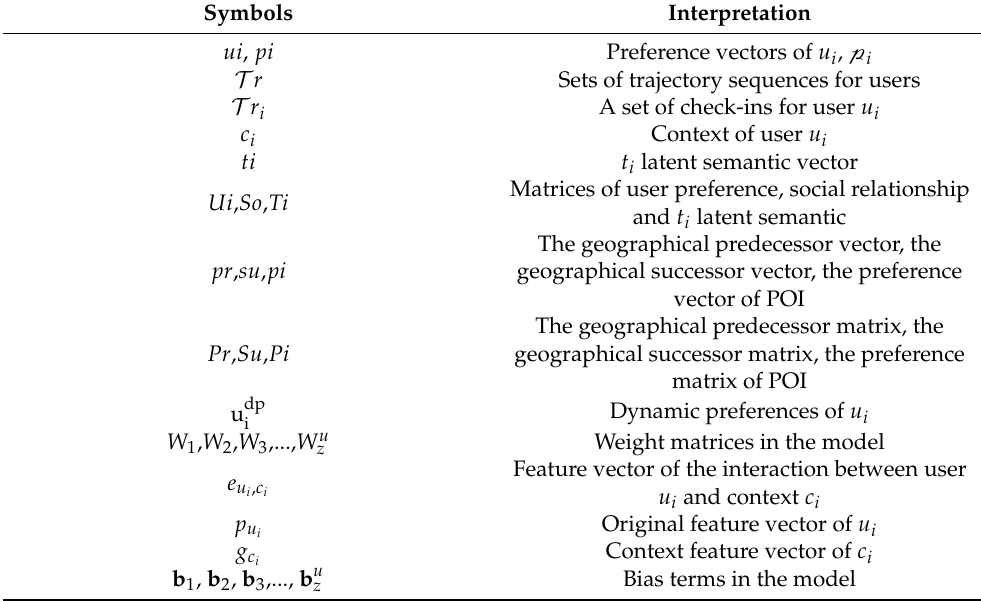
Table 1. Main Notation.